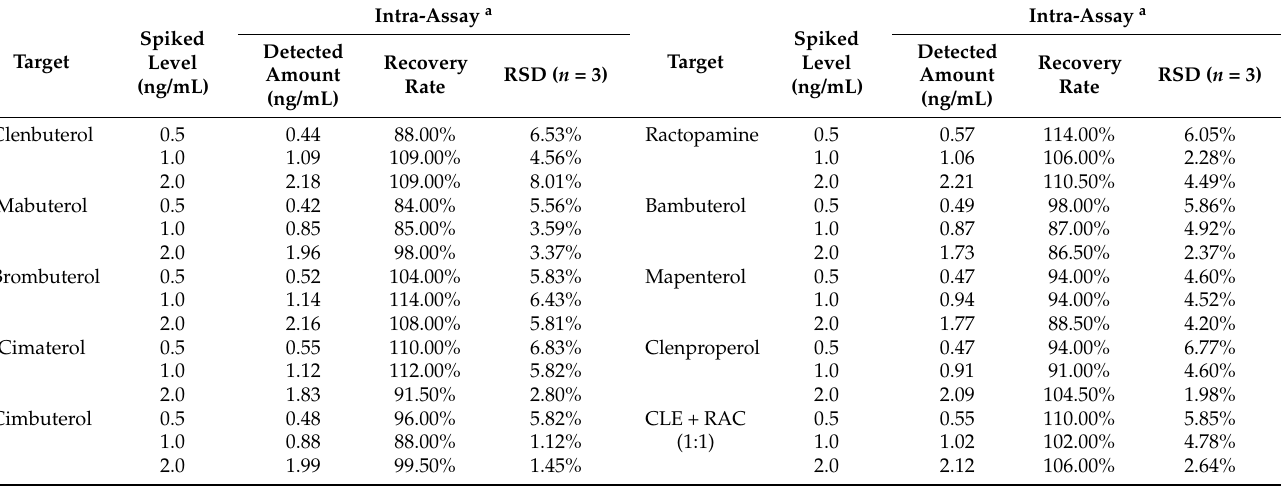
Table 2. Recovery of β 2 -agonists in swine urine samples by